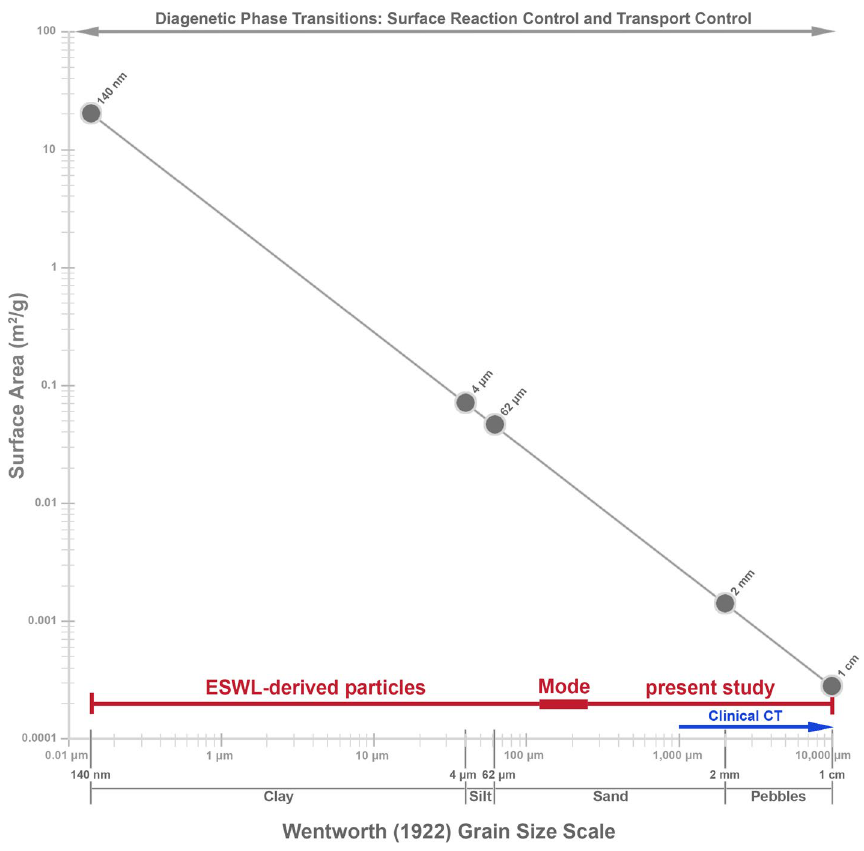
Figure 8. Log plot of specific surface area (m 2 /g) as a function of grain diameter (in microns) following the Wentworth grain size classification scheme. Surface area calculations (described in detail in the text) were made from the size frequency distributions of the experimentally measured SWL-derived particles (Fig. 7; red horizontal line) and assuming geometrically equidimensional particles. The 3–4 mm-diameter detection limit of clinical CT screening (blue line) and example 250 nm-resolution CAF microscopy images are also shown. The 3 mm resolution of non-contrast computed tomography images exclude the high-frequency crystalline architecture and overall SWL-derived particle fracture geometries. Corresponding data found in Supplementary STable